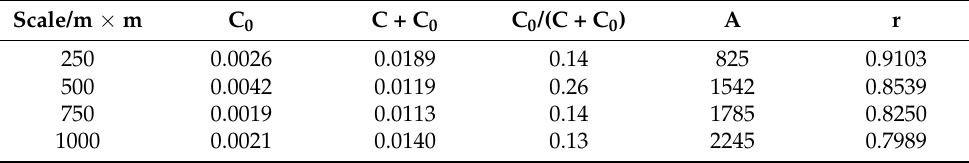
Table 2. Parameters of the semi-variogram at different grid scales. Scale/m ×